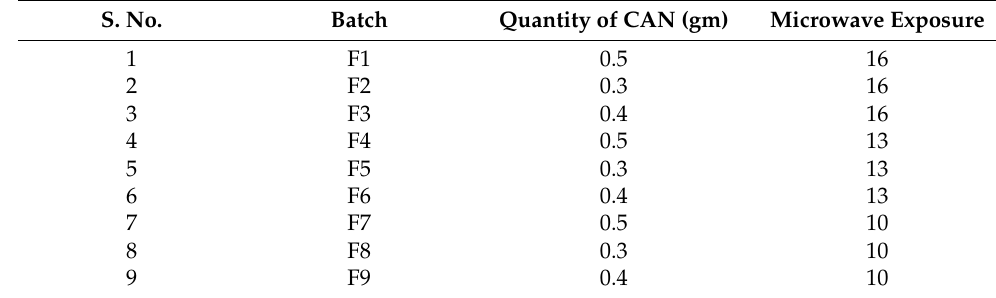
Table 1. Details of independent variables for the synthesis of graft copolymers. S. No.